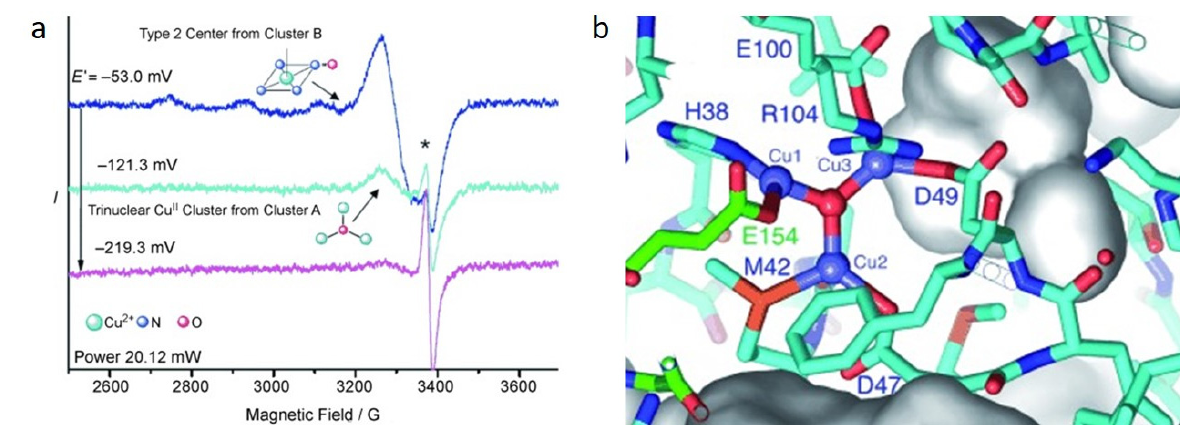
Figure 1. ( a ) EPR spectrum of the copper cluster and ( b ) Trinuclear copper site model in pMMO. Reproduced with permission from ref [32]. Copyright 2007, Wiley-VCH.